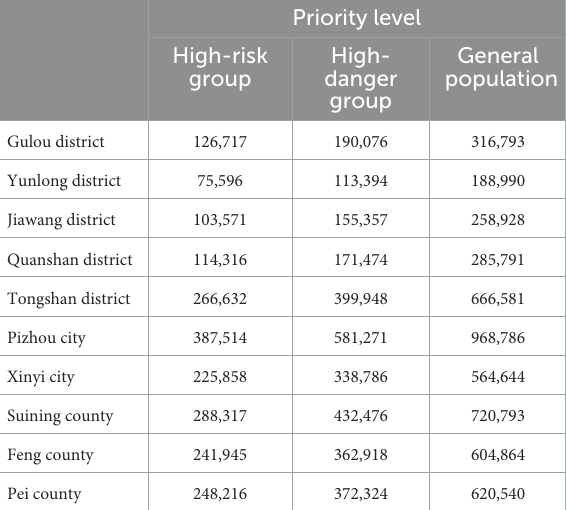
TABLE 2 Number of priority persons in each region. Priority level